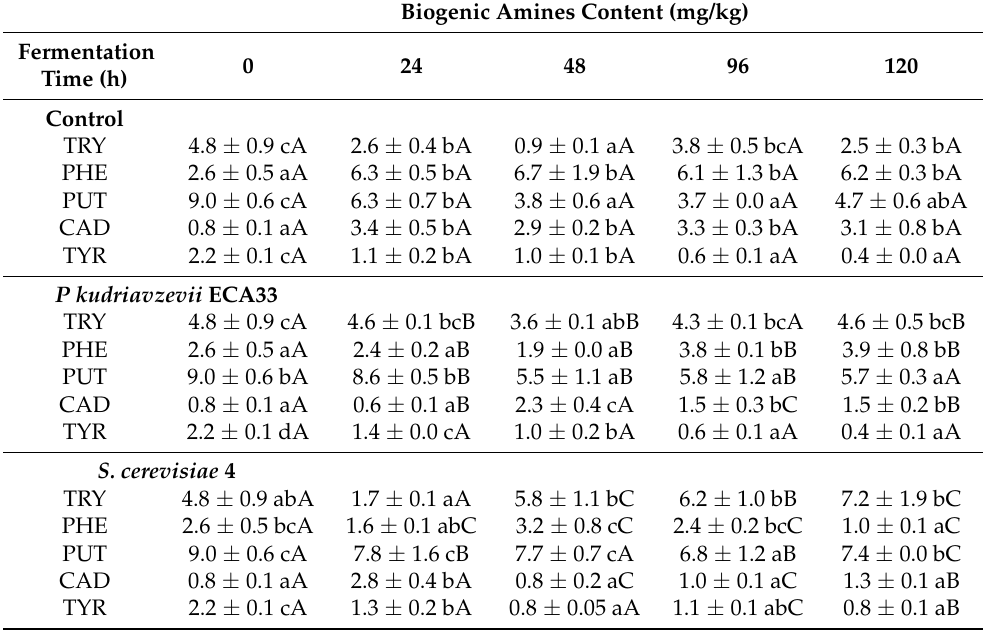
Table 2. Dynamics of the biogenic amines during cocoa beans simulated fermentation with single cultures of P. kudriavzevii ECA33 and S. cerevisiae